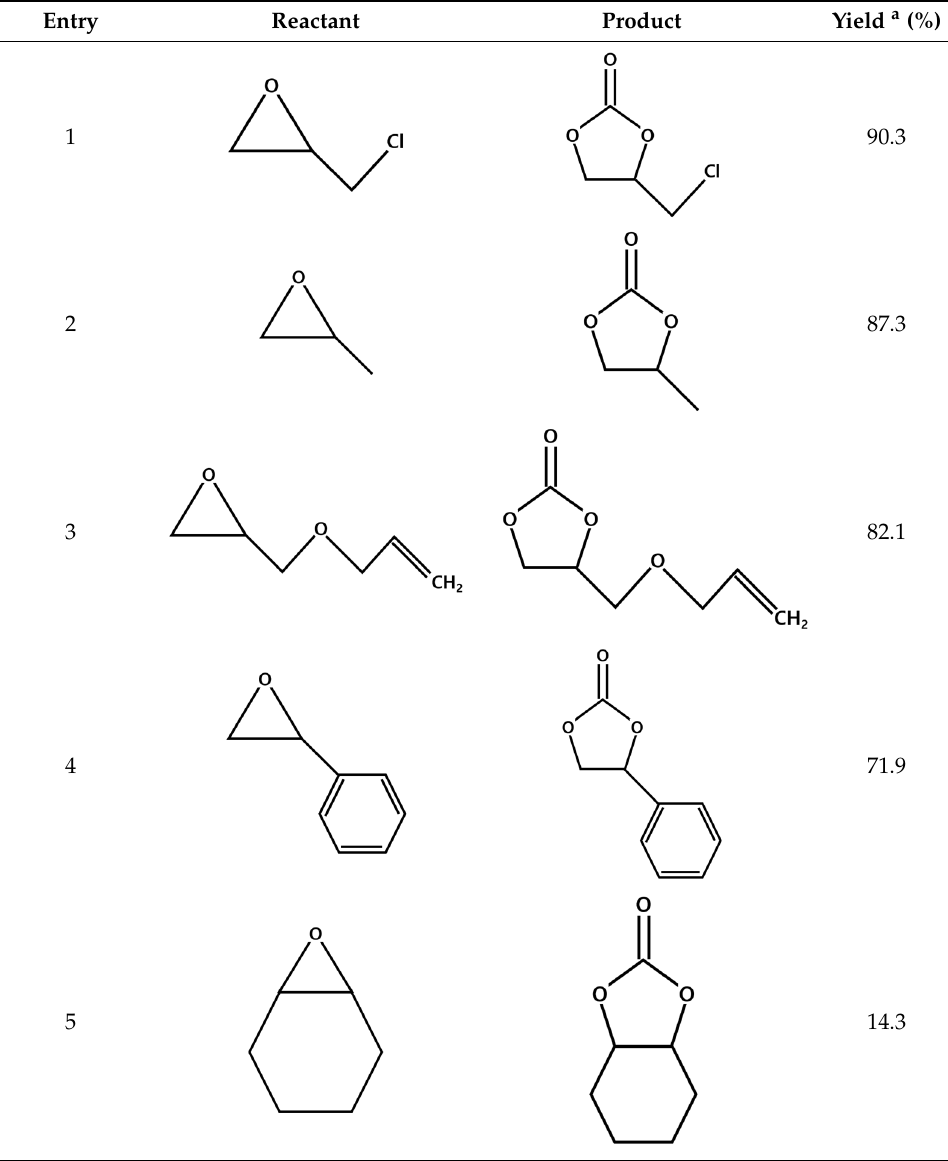
Table 4. Synthesis of cyclic carbonates from various epoxides.